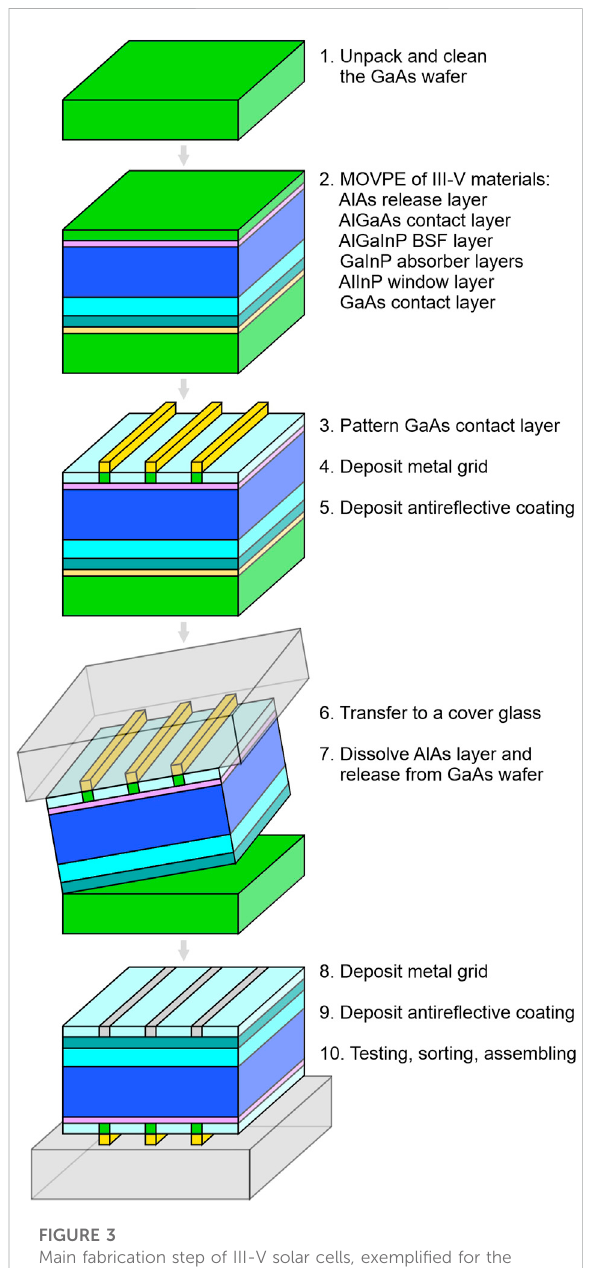
FIGURE 3 Main fabrication step of III-V solar cells, exempli fi ed for the top GaInP cell and contact layers (Karam et al., 2019).